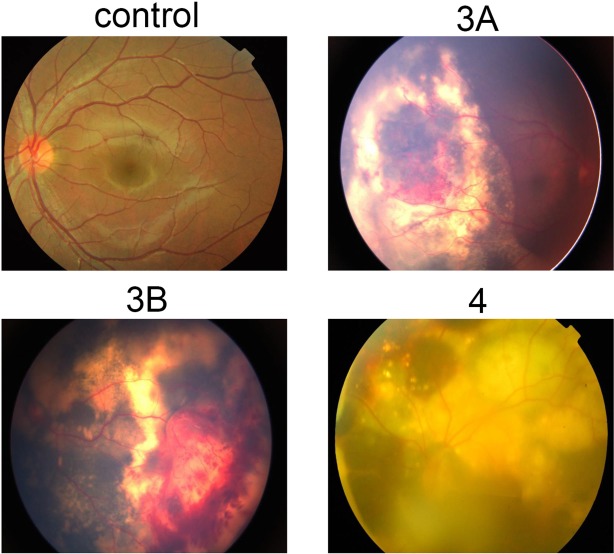
Representative fundus views of the different stages of Coats' disease, including stage 3A, stage 3B, and stage 4, and the controls.